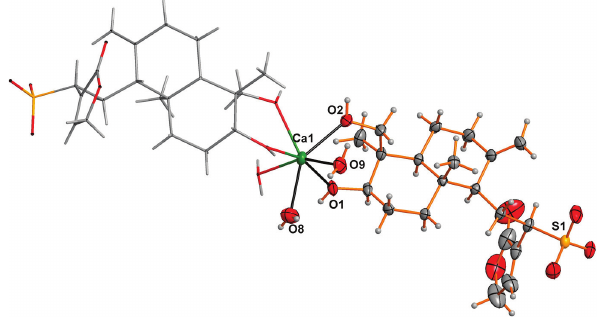
Table 1: Data collection and handling.